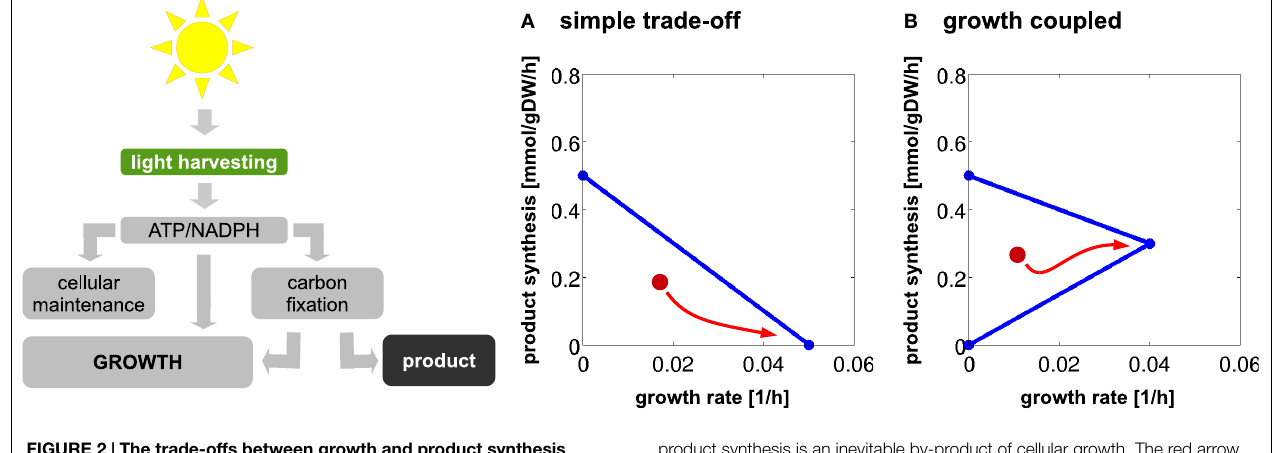
FIGURE 2 | The trade-offs between growth and product synthesis . Light energy harvested by the photosynthetic light reaction is either used for cellular growth, for growth-independent maintenance, or diverted into product synthesis. (A) A simple trade-off between growth and product synthesis. (B) Growth-coupled product synthesis. In the latter case,